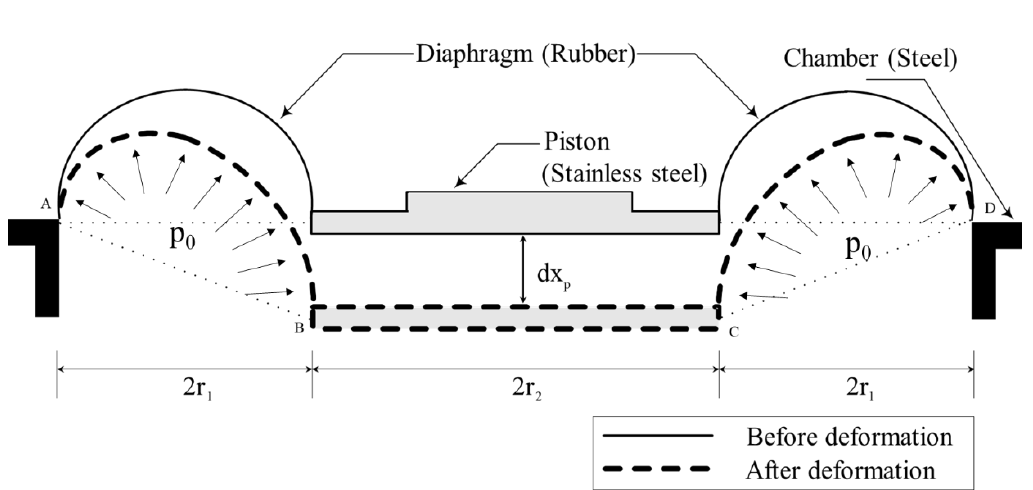
Figure 11. Assumption of the diaphragm movement for the calculation of equivalent piston area A p .